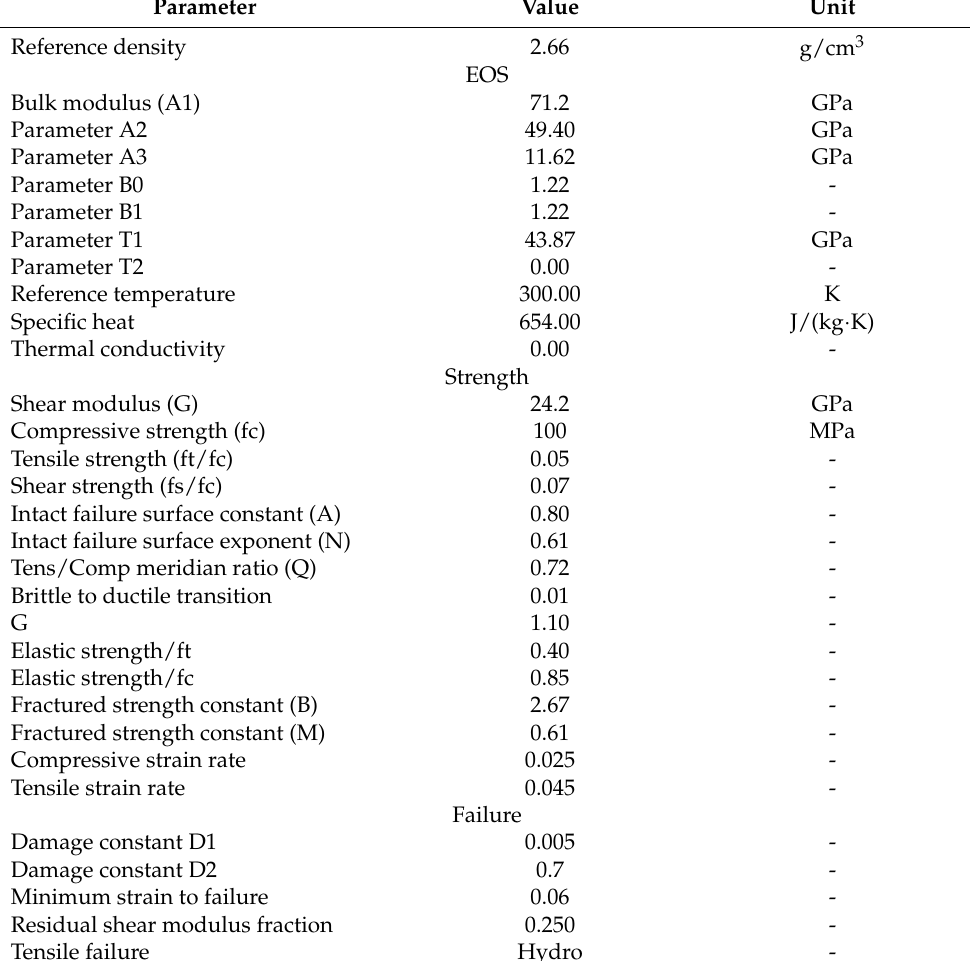
Table 1. Numerical constants used in AUTODYN for Limestone